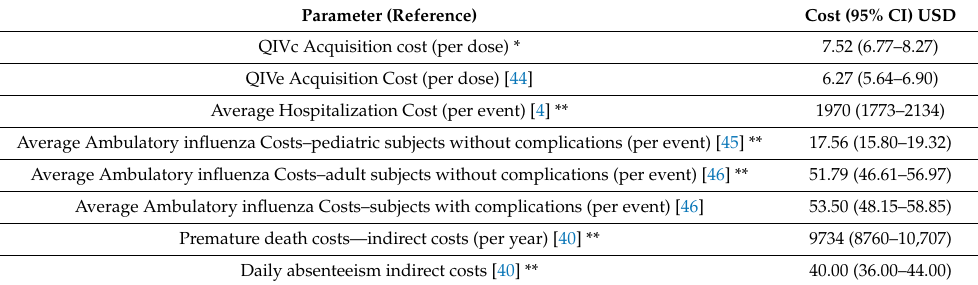
Table 2. Costs inputs.